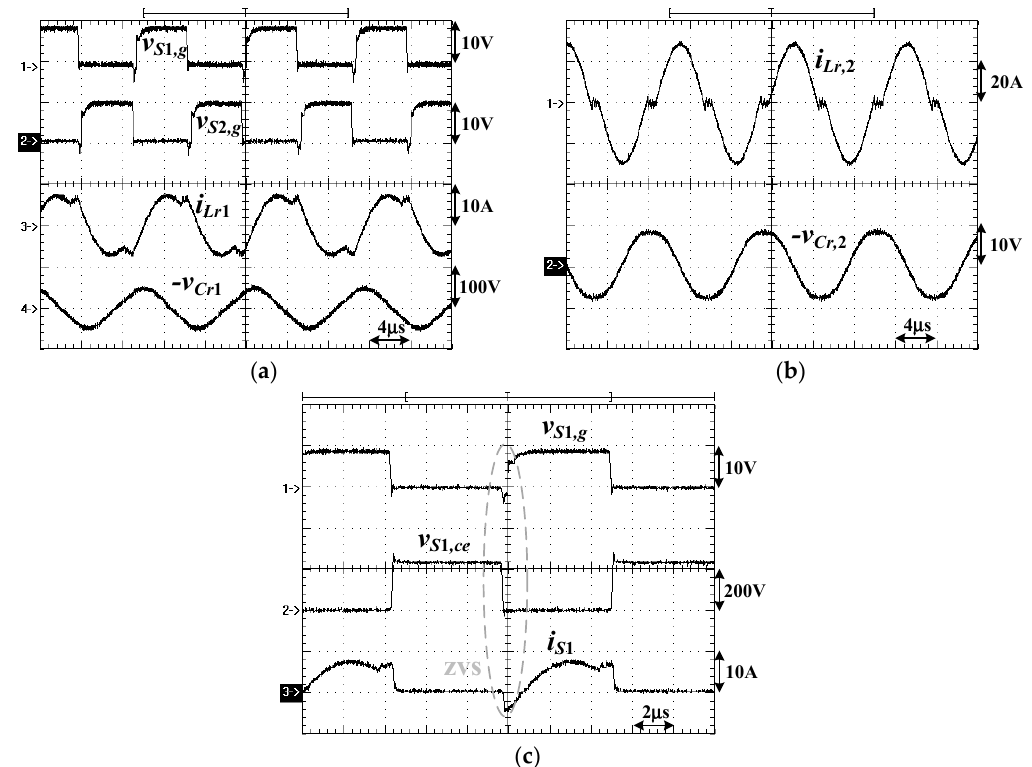
Figure 10. Measured results of the proposed converter under V in = 238 V, V o = 52 V, and I o = 7.8 A: ( a ) v S 1, g , v S 2, g , i Lr, 1 , and – v Cr, 1 ; ( b ) i Lr, 2 and – v Cr, 2 ; ( c ) v S 1, g , v S 1, ce , and i S 1 .